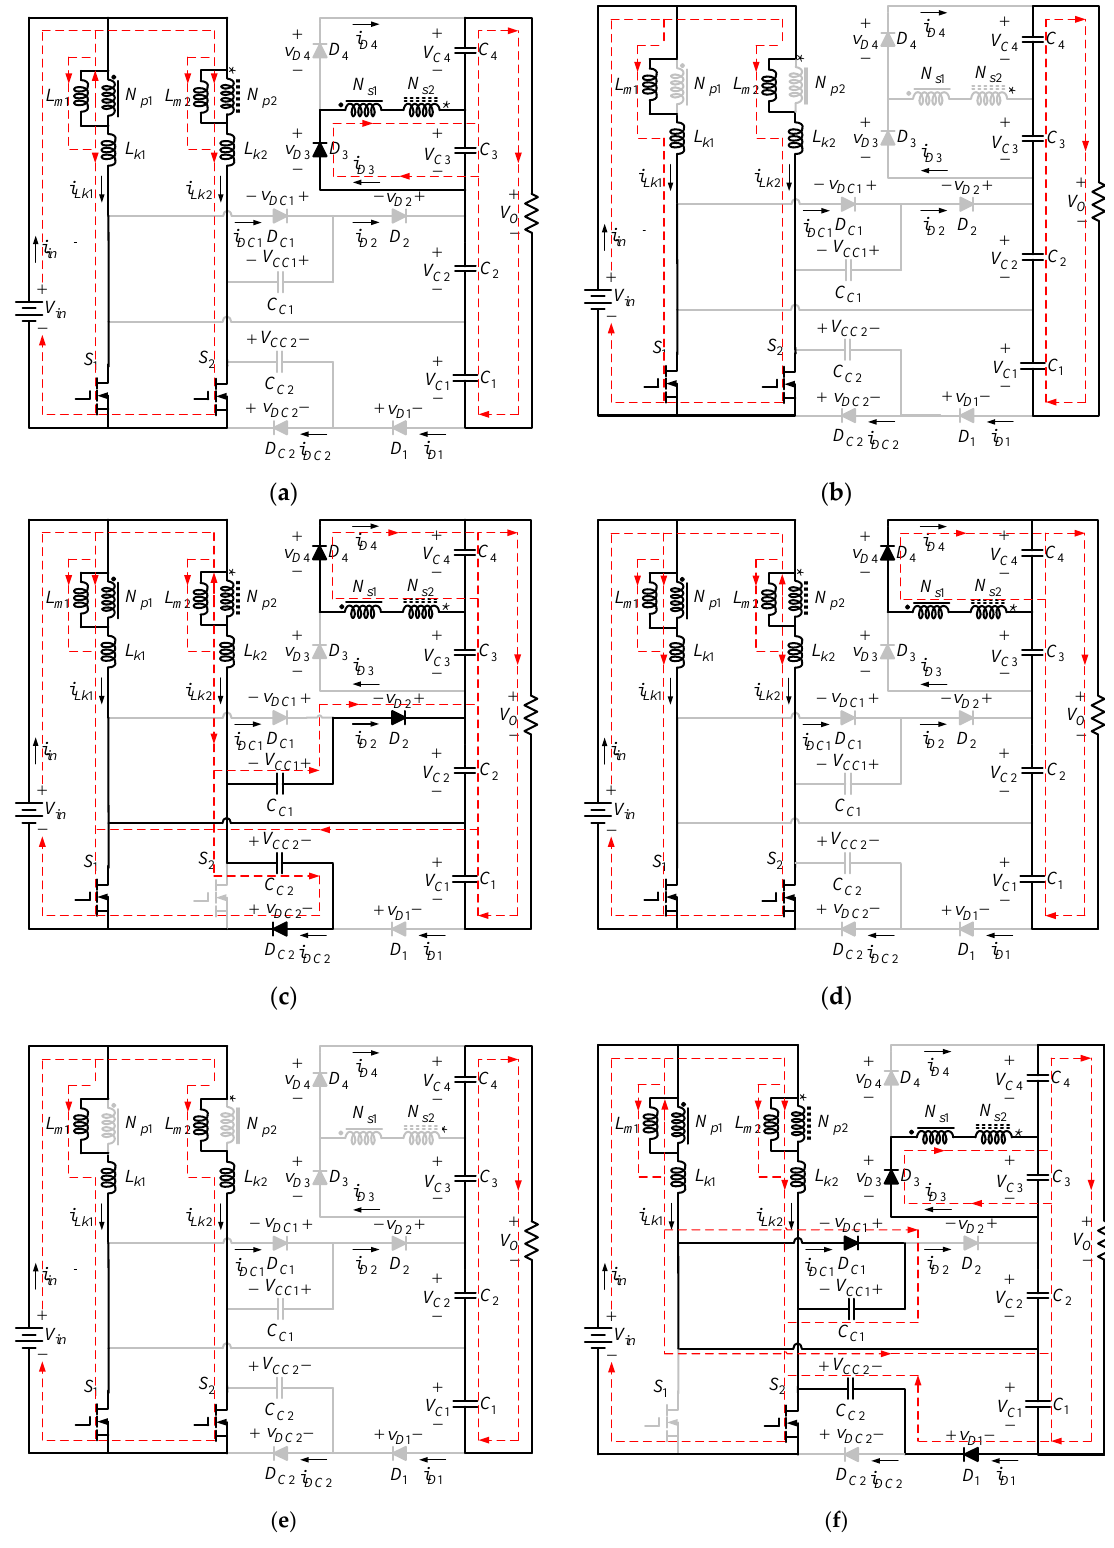
Figure 4. Operating modes of the proposed converter. ( a ) Mode 1; ( b ) Mode 2; ( c ) Mode 3; ( d ) Mode 4; ( e ) Mode 5; ( f ) Mode 6.